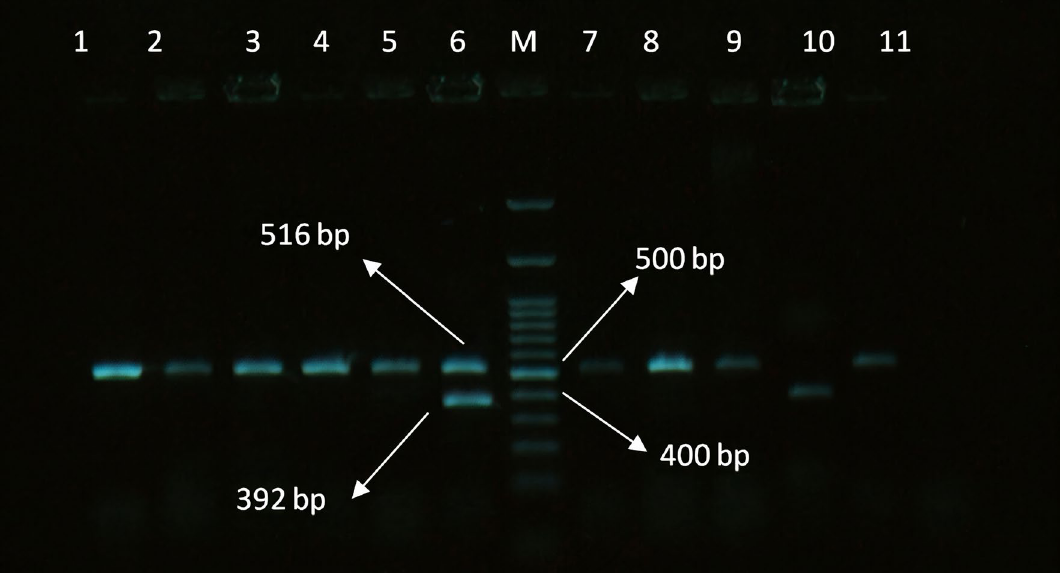
Figure 1. Electrophoresis pattern obtained by multiplex PCR for detection of bla TEM and bla SHV genes in E. coli isolates. M: marker 100 bp; lane 1, 2, 3, 4, 5, 6, 7, 8, 9, 11: amplification of bla TEM gene at 516 bp; lane 6, 10: amplification of bla SHV gene at 392 bp.